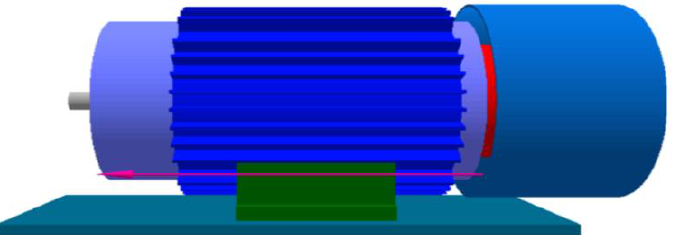
Figure 5. Motor (fan-cooled) drawn using Motor-CAD software (according to specifications of the chosen motor).